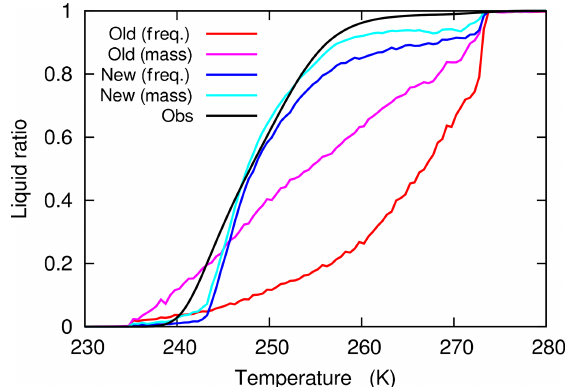
Figure 4. Ratio of supercooled liquid water to total cloud water as a function of temperature. The plot is obtained from snapshot of global data for 10d in July 2001 using the old (red and pink lines) and new (blue and light blue lines) treatments of the WBF effect. The ratios are calculated using two methods: mass-weighted ratio (pink and light blue lines), in which liquid and ice masses are averaged over temperature bins first and the liquid water ratio is calculated from the averaged masses, and frequency ratio (red and blue lines), in which the snapshot ratio of liquid water is weighted by snapshot cloud fraction and averaged over temperature bins. An observational curve from Hu et al. (2010) that corresponds to a fre- quency ratio is also shown (black line).